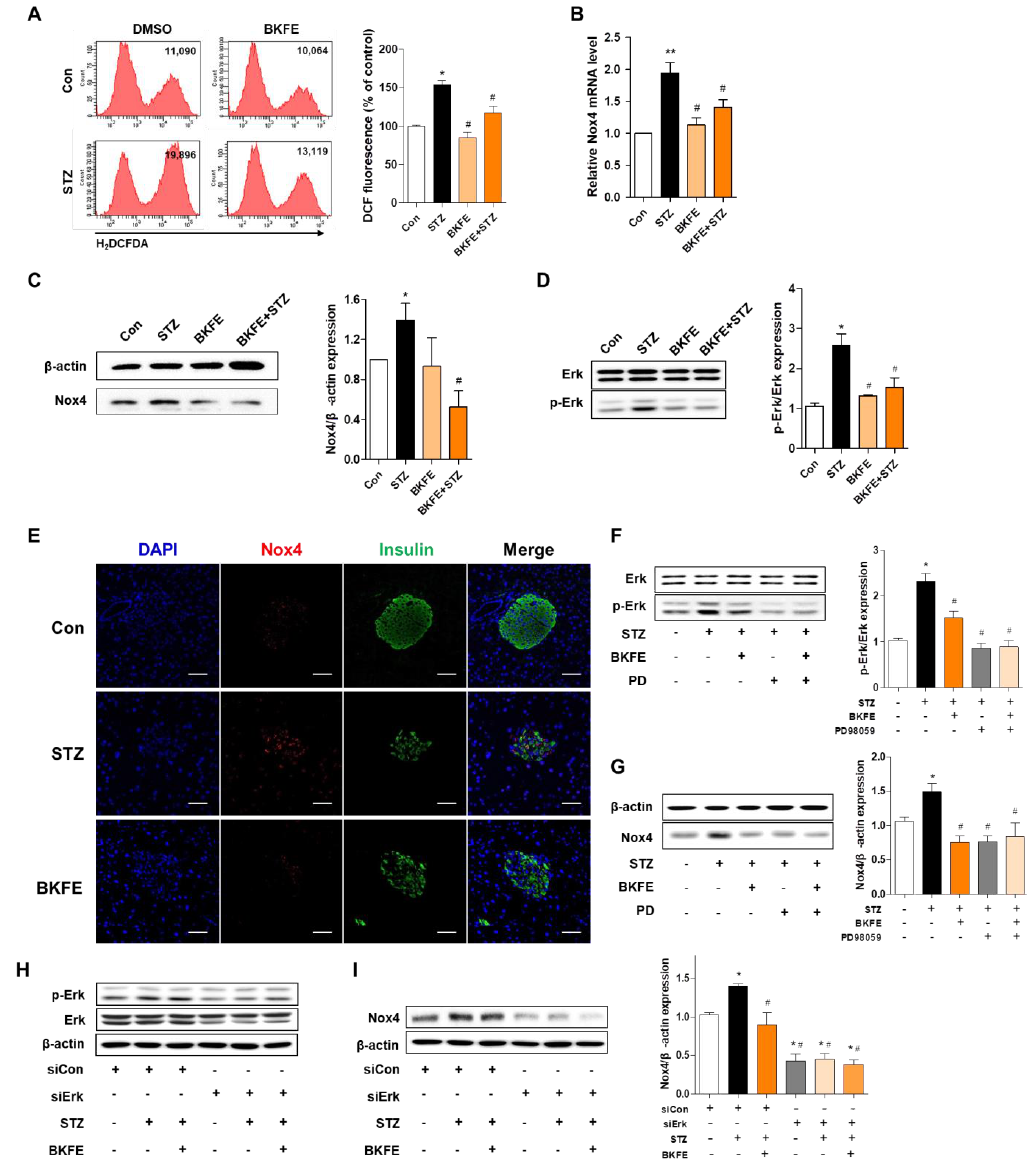
Figure 6. BKFE inhibits STZ-induced production of ROS by downregulation of p-Erk/Nox4 pathway in MIN6 cells and mice. ( A ) The cells were treated as described in Figure 5, and the cells were stained with H 2 DCFDA and analyzed by flow cytometry. Values on the representative flow cytometry data indicate the DCF fluorescence intensity of whole cells. The bar graph shows quantitative data for the percentage of intracellular ROS generation. ( B ) Nox4 mRNA values were analyzed by quantitative RT-PCR from three independent experiments . MIN6 cells were pretreated with 10 μg/mL of BKFE for 1 h and then further incubated with 10 mM STZ for 1 h ( C ) or 30 min ( D ) to detect Nox4, Erk, and p-Erk levels. Con, Vehicle + citrate buffer; STZ, Vehicle + STZ; BKFE, BKFE + citrate buffer; BKFE + STZ, BKFE + STZ. ( E ) Immunohistochemical detection of Nox4 in pancreatic sections from experimental mice treated with STZ and/or BKFE and non-diabetic controls. Representative images showing the expression of Nox4 (red) and